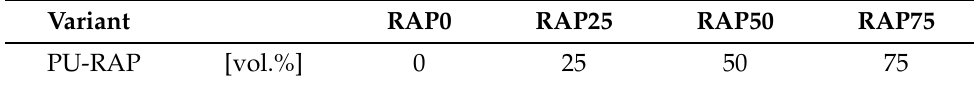
Table 2. Substituted PU-RAP proportion of the aggregates